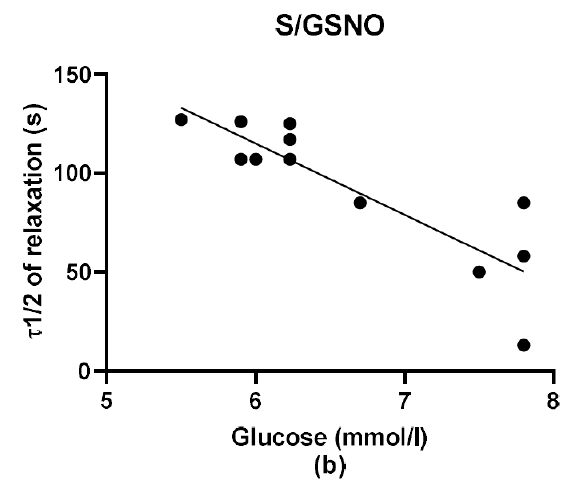
Figure 10. The mutual relationship between plasma glucose levels and the time required to reach 50% of the maximum relaxation ( τ 1 / 2) induced by GSNO ( a ) and S / GSNO products ( b ). The speed of relaxation induced by S / GSNO products positively correlated with the glucose level of patients (Y = − 36.03*X + 331.2).